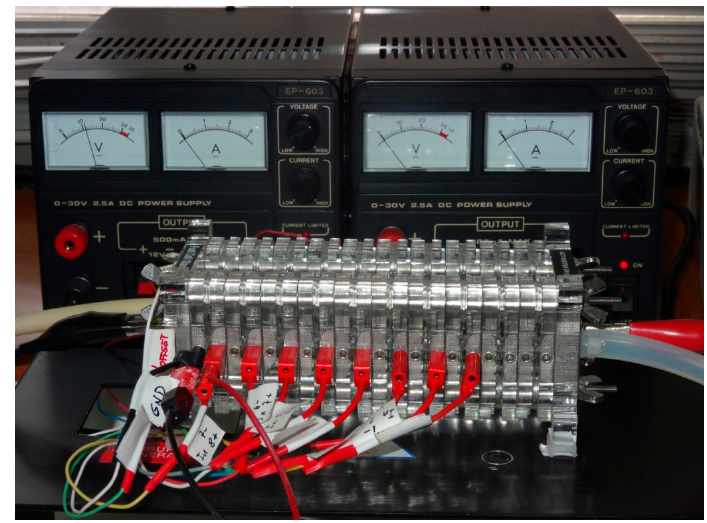
Figure 9. PE stack assembled and wired under laboratory tests.